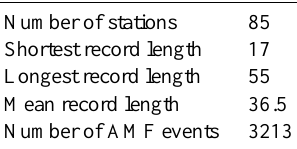
Table 1. Summary of AMF data sets used in the